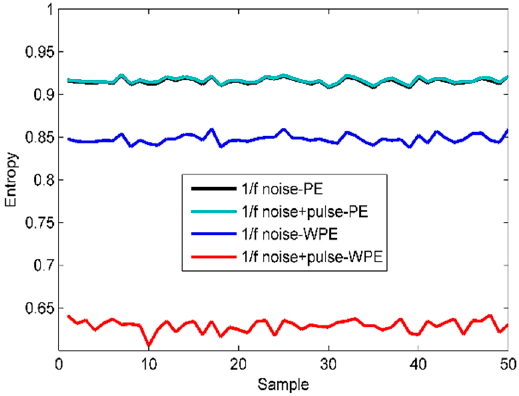
Figure 8. The scatter plots of calculation results for PE and WPE.